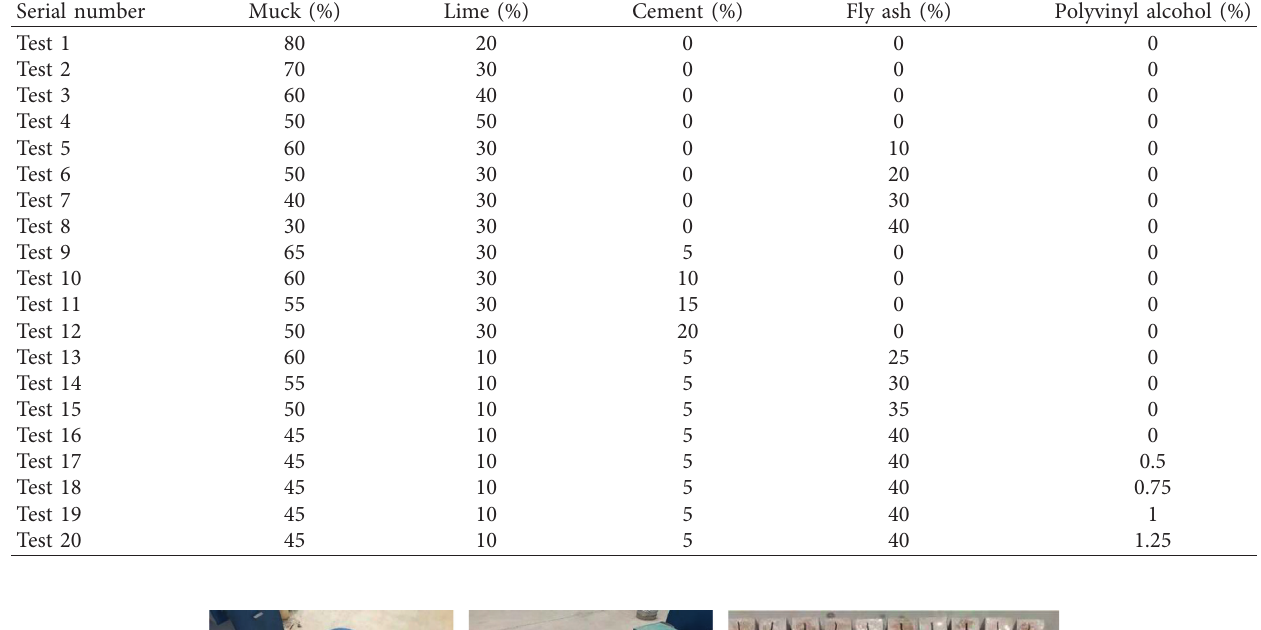
Table 2: Experimental program.